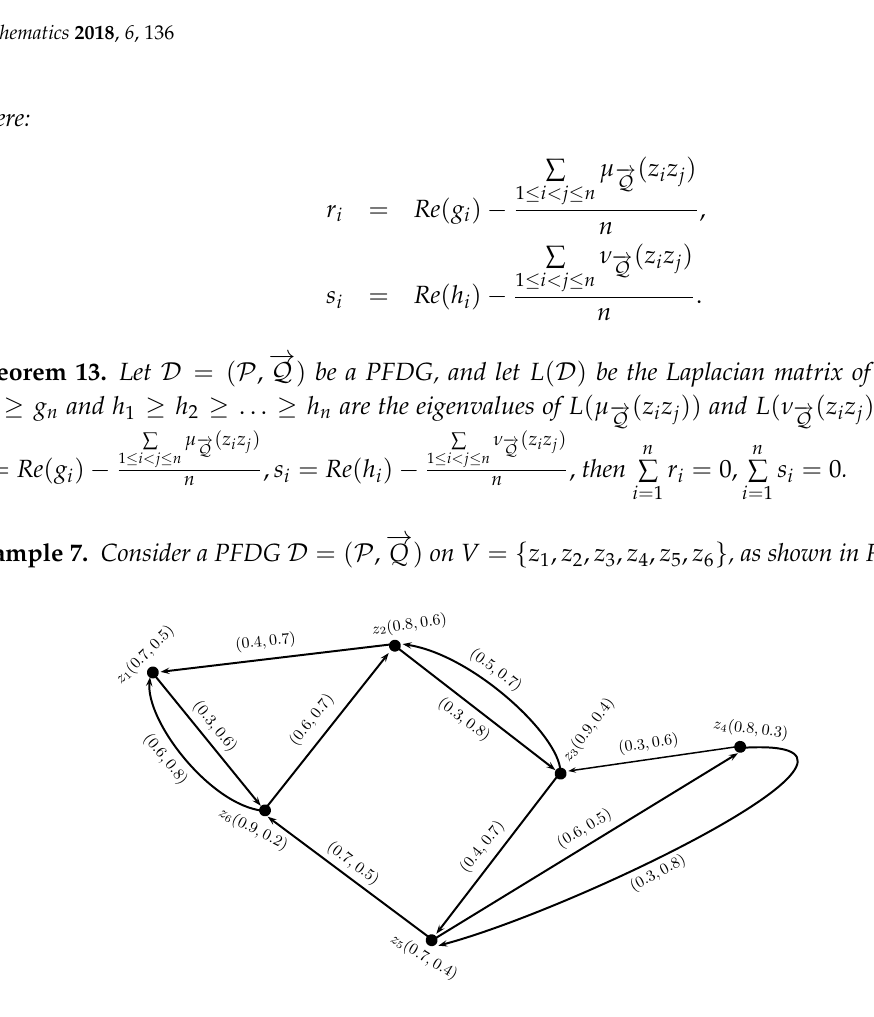
Figure 5. Pythagorean fuzzy